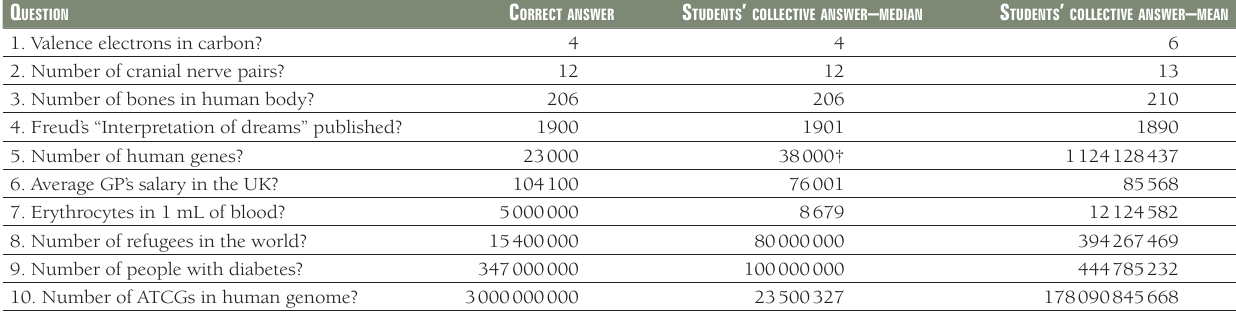
Table 3. Year 2 undergraduate medical students’ collective answers to the 10 questions in the area of their knowledge*